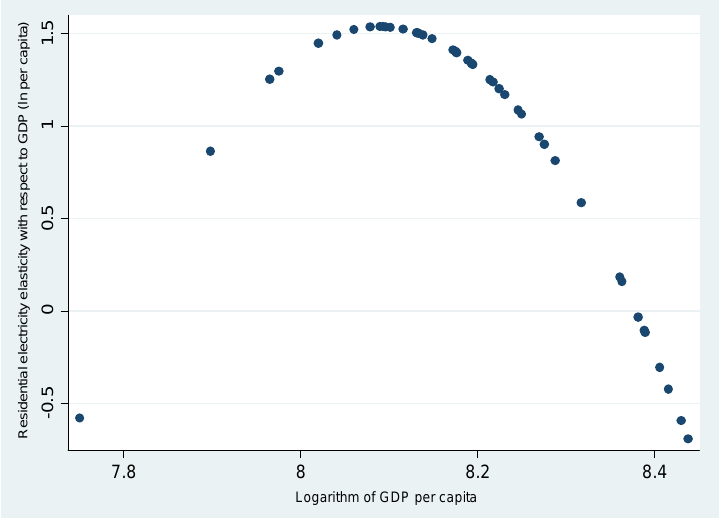
Figure 2. Residential electricity consumption elasticity with respect to GDP per capita.